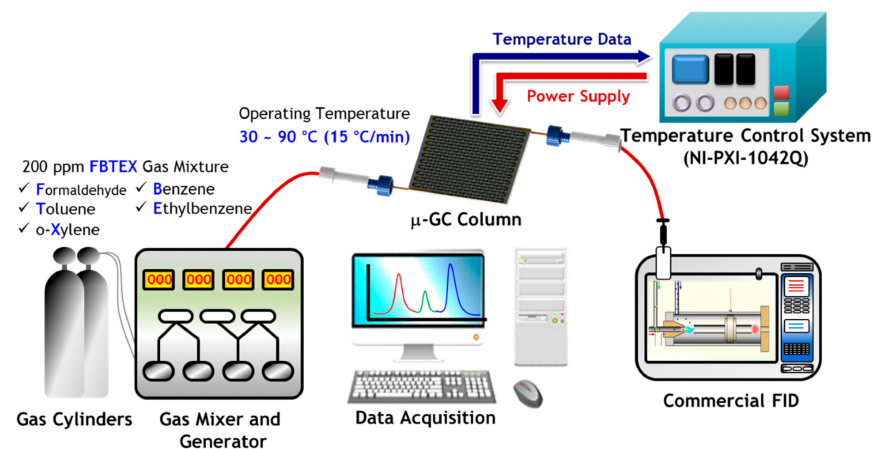
Figure 4. Schematic of the experimental setup used to test the separation performance of the GC columns. The sample amount of 50 µ L of FBTEX mixture gas with a concentration of 200 ppm was injected into the µ -GC column by the gas mixer and generator, and nitrogen was used as the carrier gas at a flow rate ranging from 0.3 sccm to 0.4 sccm. The temperature of the µ -GC column was maintained at 30 ◦ C for 1 min, ramped to 90 ◦ C at a ramping rate of 15 ◦ C / min, and then maintained at 90 ◦ C for 1 min. The temperature programming of the column was performed by micro-heaters and RTS of the µ -GC column using the hardware control system. The gas components separated through the µ -GC column were detected by the commercial FID; the separation results are shown through the data acquisition